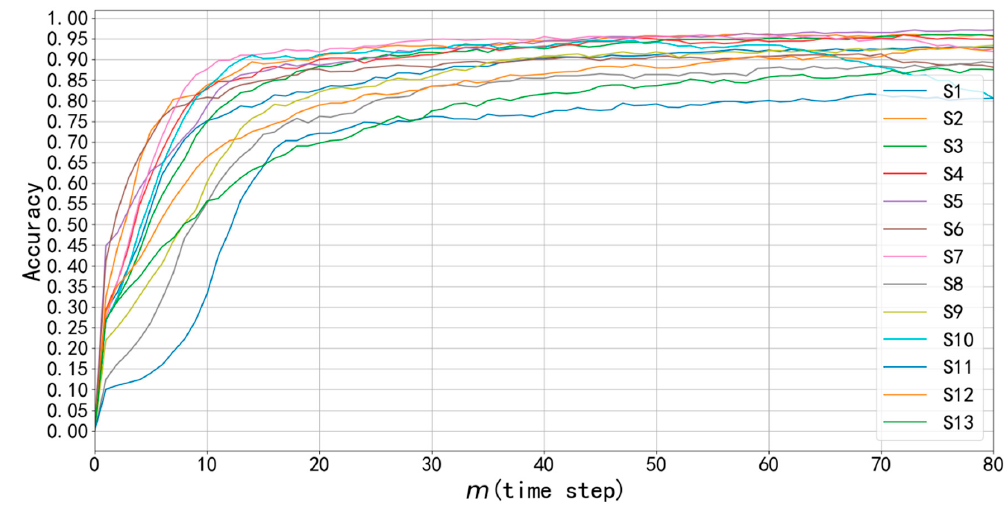
Figure 7. Accuracy with respect to 𝑚 on 13 subjects. The horizontal axis 𝑚 denotes how many time steps of sEMG data are used to predict gesture. Additionally, the vertical axis denotes the average accuracy of 5-fold cross validation. accuracy of 5-fold cross validation. Table 2. Prediction accuracy with different 𝑚 .